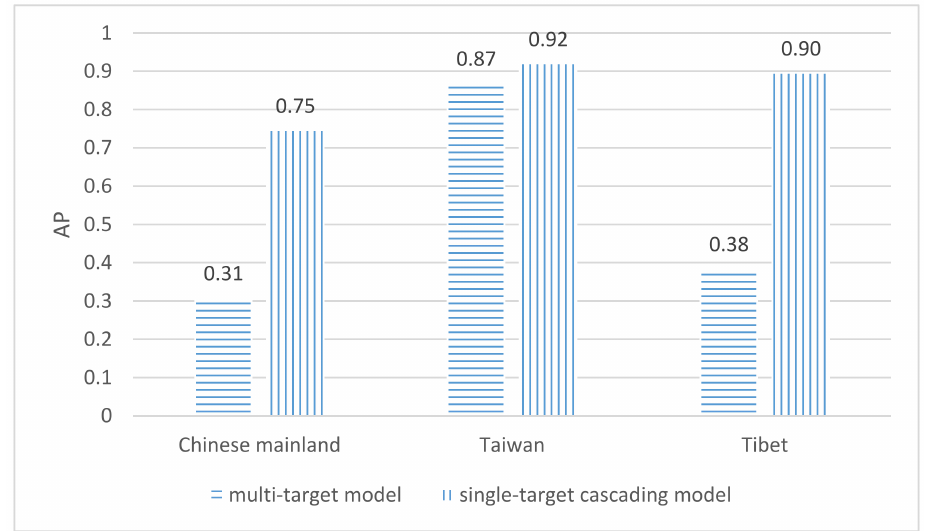
Figure 7. Comparison of AP between the single-target cascading model and the multi-target model.